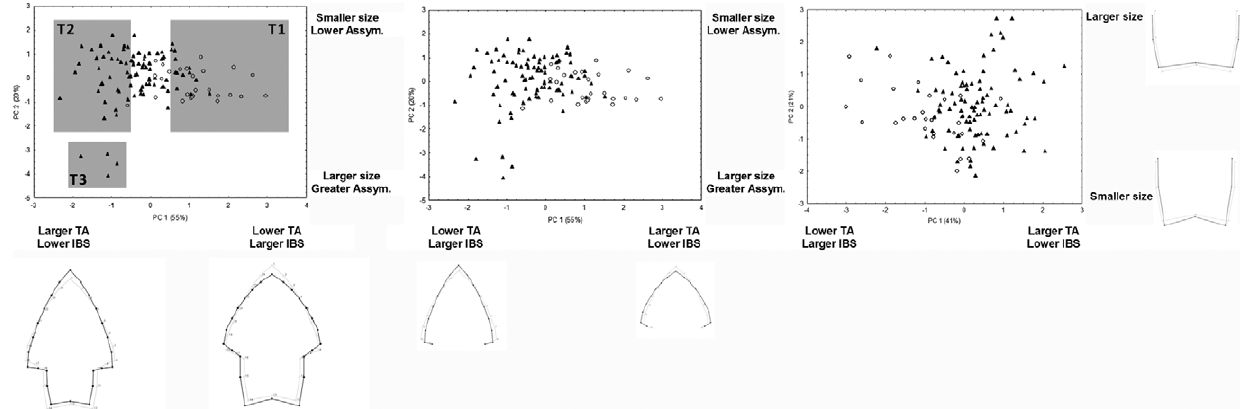
Figure 3. Composite principal component analysis. Scatterplot of the two first principal components performed on the first PC of shape, size, IBS, TA, and asymmetry values. A) Whole point shape analyzed; b) only blade shape analyzed; c) only stem shape analyzed. The color of the points indicate classification of points as Bird IV (solid triangles), Bird V (empty circles) types according to Bird [23–25]. T1, T2 and T3 represent arbitrary groupings aimed to repeat the modularity analysis on arrays of points sharing similar attributes.